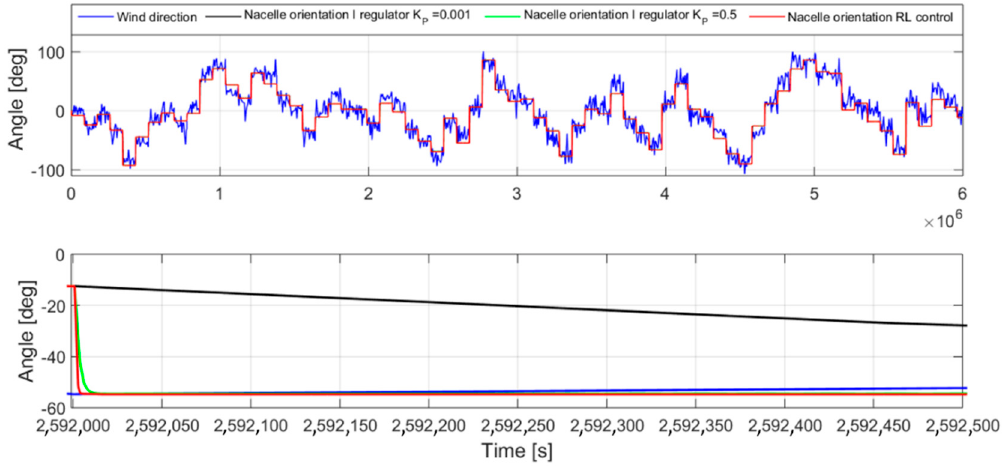
Figure 16. Performance comparison of the conventional and the proposed RL based yaw control algorithms.